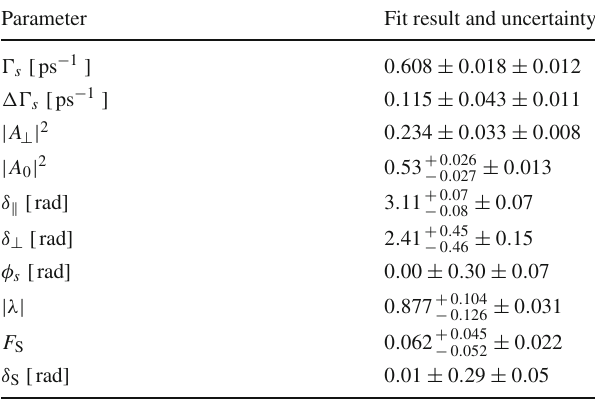
Table6 Resultsofthemaximum-likelihoodfitdescribedinSection6to the B 0 s → J /ψ( e + e − ) φ decays including all acceptance and resolution effects and with the mixing frequency fixed to the PDG value, (cid:5) m s = 17 . 757ps − 1 [15]. The first uncertainty is statistical and the second is systematic, which is discussed in Sect. 7